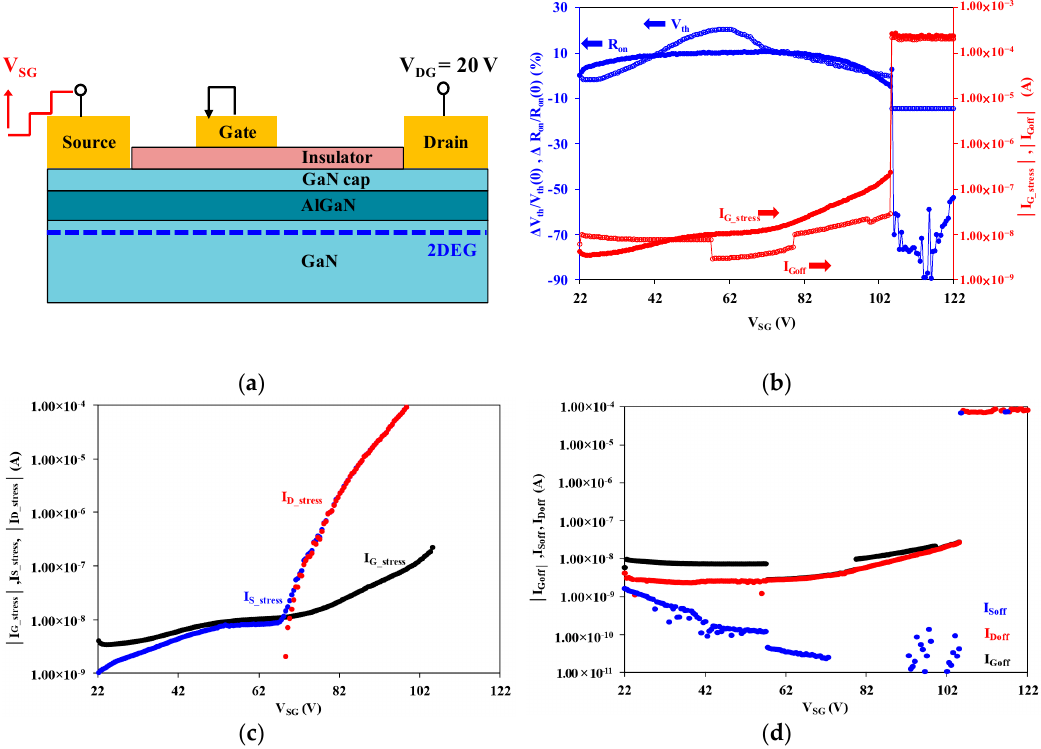
Figure 7. ( a ) Sketch of MIS-HEMTs under source voltage step-stressing at off-state from V SG = 22 V to 122 V in 0.5 V step (measured at V DG = 20 V); ( b ) Normalized V th , R on (left axis), I G_stress and I Goff (right axis) as a function of V SG in a V DG = 20 V step–stress experiment; ( c ) 3-terminals I-V characteristics acquired during stress. A sudden increase of drain (I D_stress ) and source (I S_stress ) current is measured at V SG = 67 V; ( d ) 3-terminals leakage currents acquired after stress.